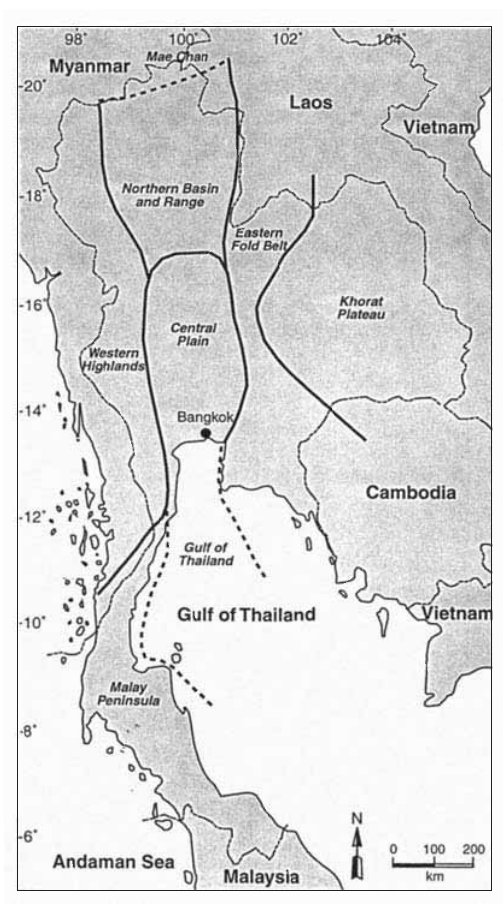
Fig. 2. Seismotectonic provinces in Thailand (after Woodward-Clyde Federal Services,